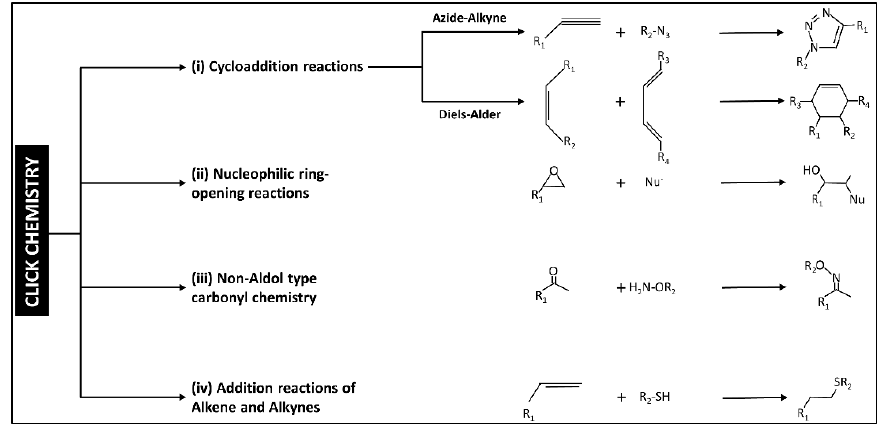
Figure 3. The scheme shows the classification of click chemistry reactions into four main categories. The scheme has been reproduced from another article [13] with permission from Elsevier, 2022.